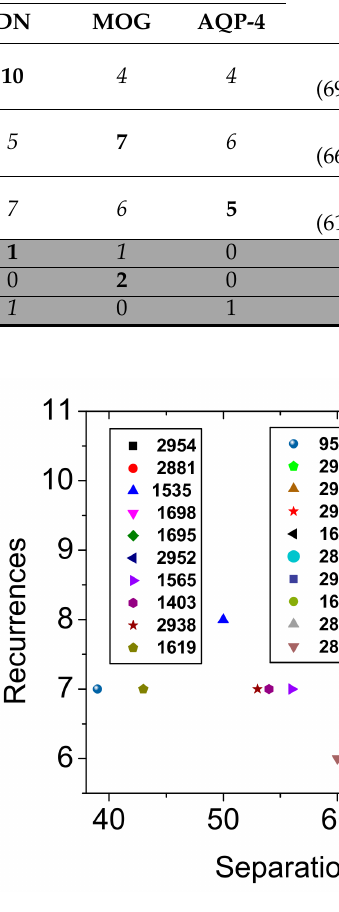
Figure 4. Scatterplot of the top 20 nodes with the highest recurrence in the random forest model of Table 2 and their corresponding percentage of separation